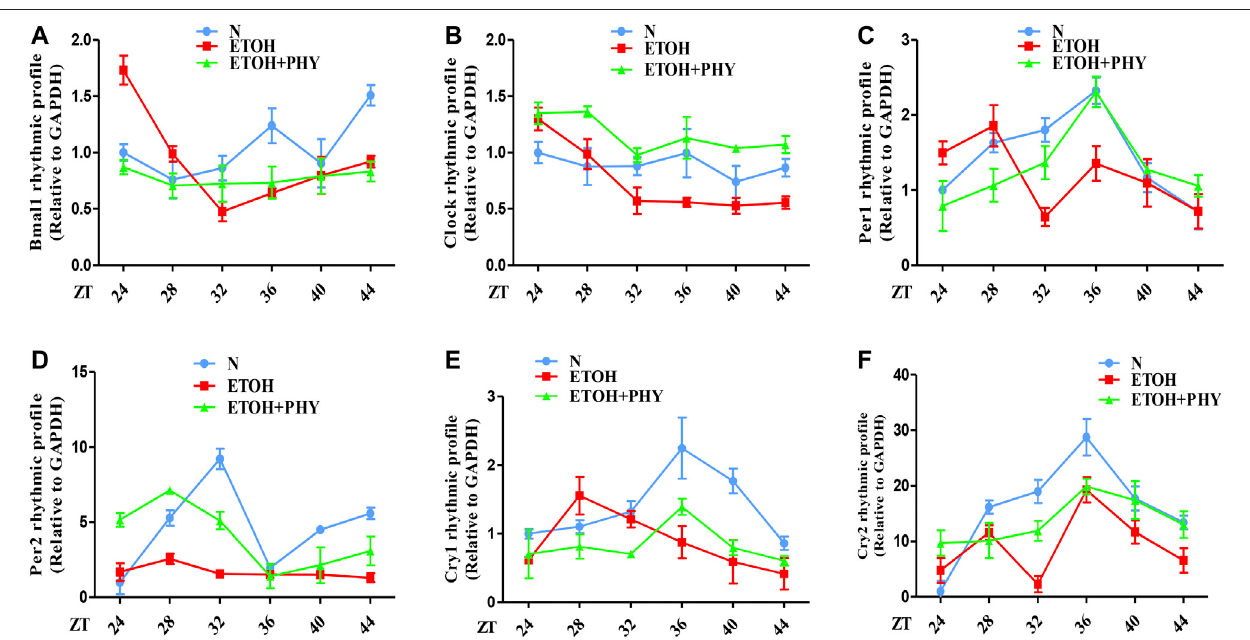
FIGURE 6 | Effects of physcion on ethanol-induced circadian dysregulation in HepG2 cells. (A – F) The mRNA expression of Bmal1, Clock, Per1, Per2, Cry1, and Cry2 in HepG2 cells.